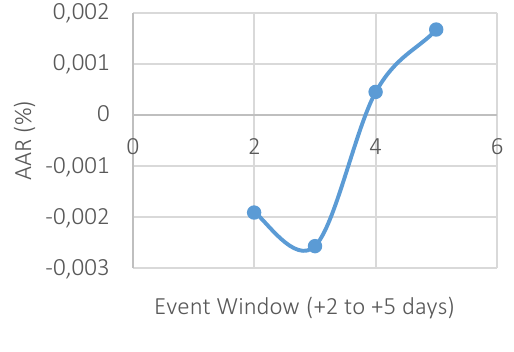
Figure 11. Average abnormal returns for the period of (+2, +10)